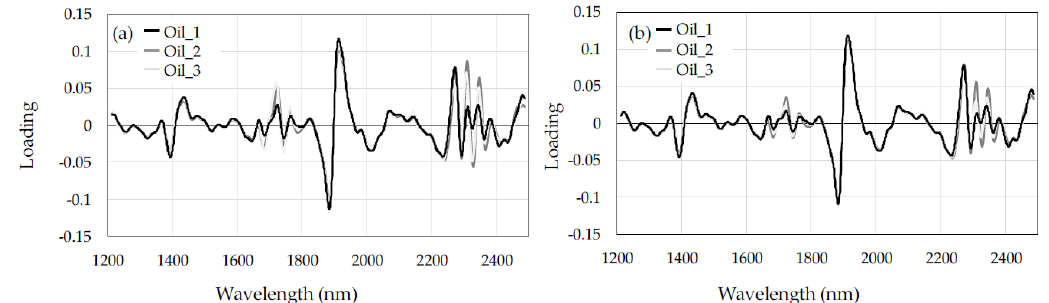
Figure 3. PC1 loading plots for oil-treated ( a ) Cryptomeria japonica and ( b ) Chamaecyparis obtusa .